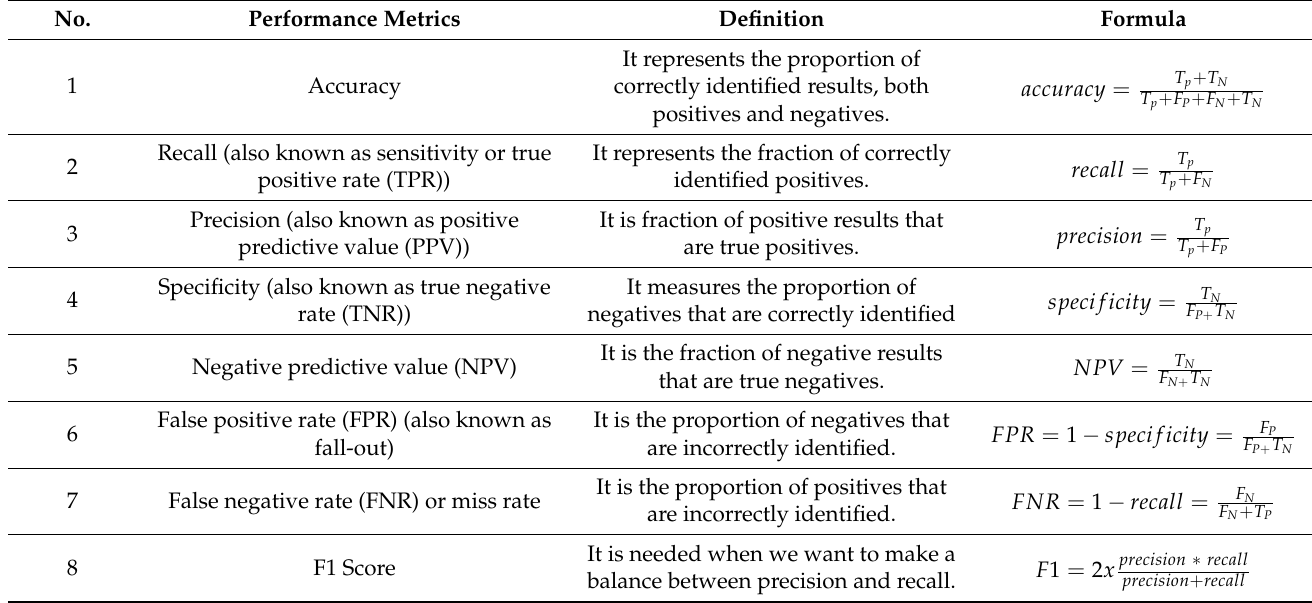
Table 7. Performance metrics and definition and